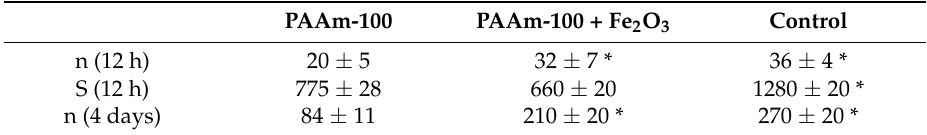
Table 5. The results of the evaluation of the adhesive and proliferative activity of human dermal fibroblasts on the surface of PAAm-100 gels with and without iron oxide γ -Fe 2 O 3 nanoparticles. n—the average number of adhered cells in the field of view in 12 h and four days after seeding; S—the average area (in square micrometers) of the adhered cells in 12 h after seeding; The results are presented as M´ ± m ( n = 30). Asterisks reflect significant differences ( p < 0.05) of the corresponding indicators with PAAm-100